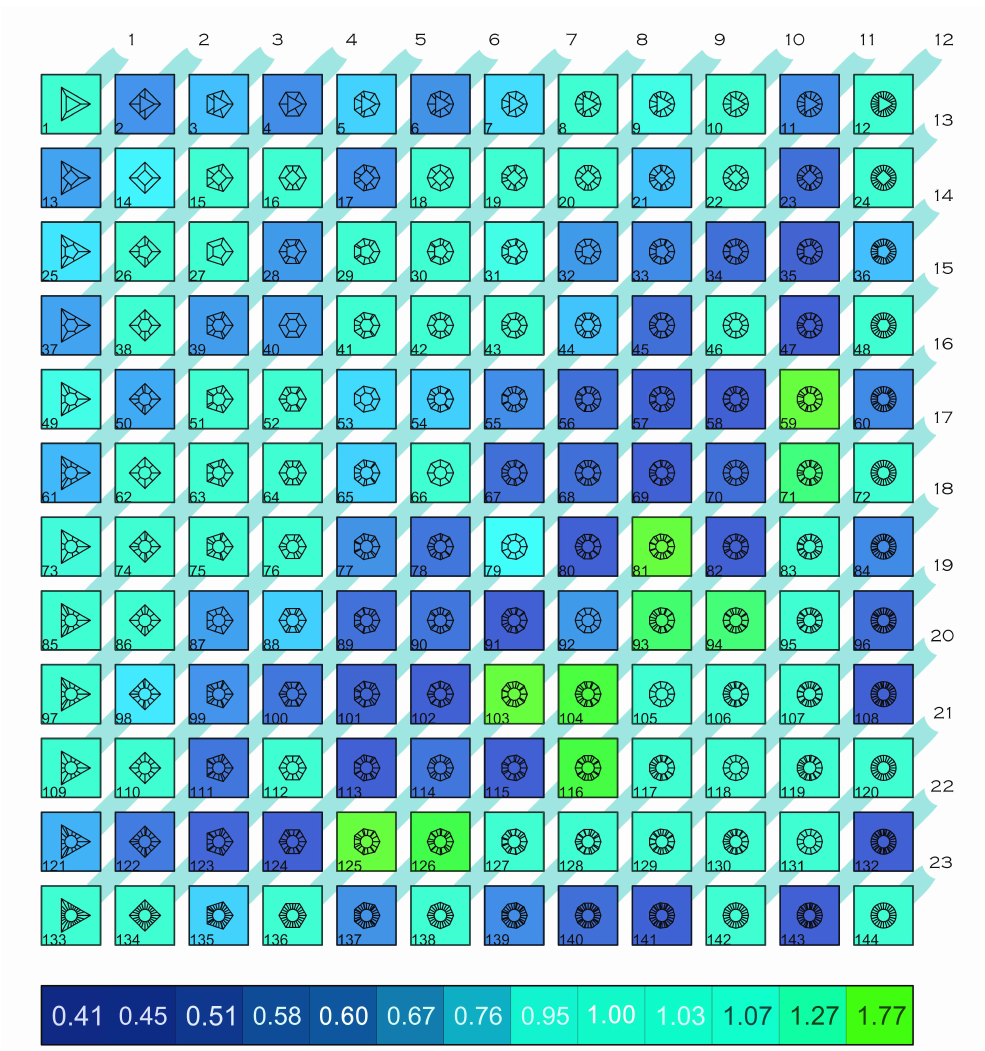
Figure 3. Colour-coded diagram depicting the structural response, in terms of drift, for the considered 144 tall building models.